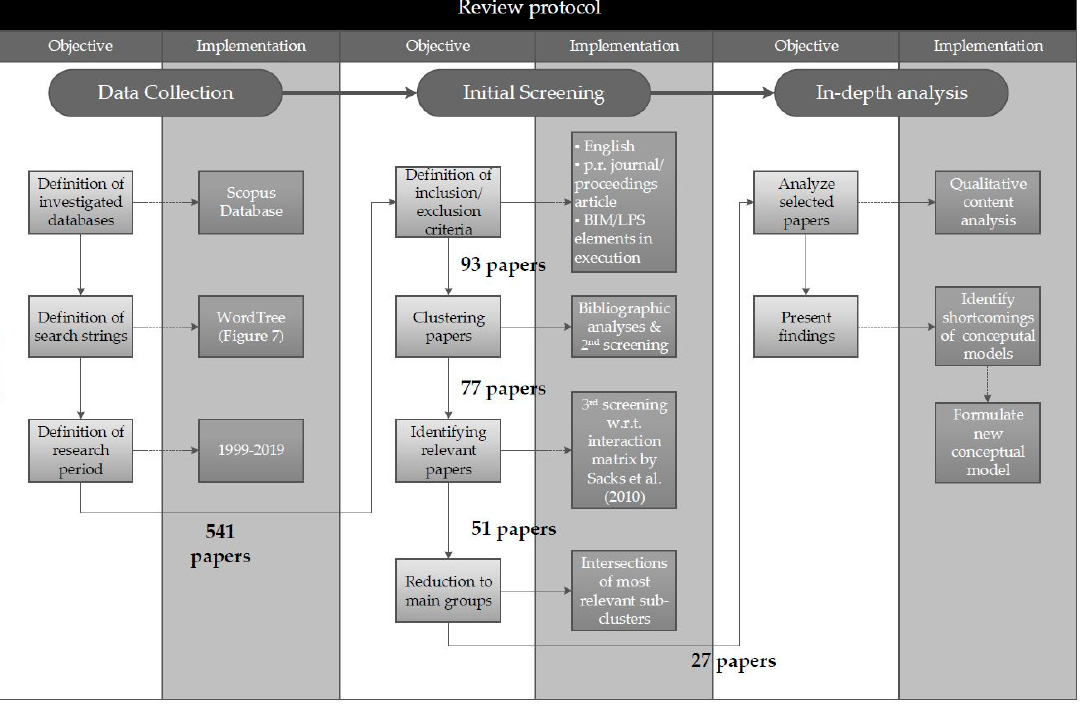
Figure 3. Review protocol.